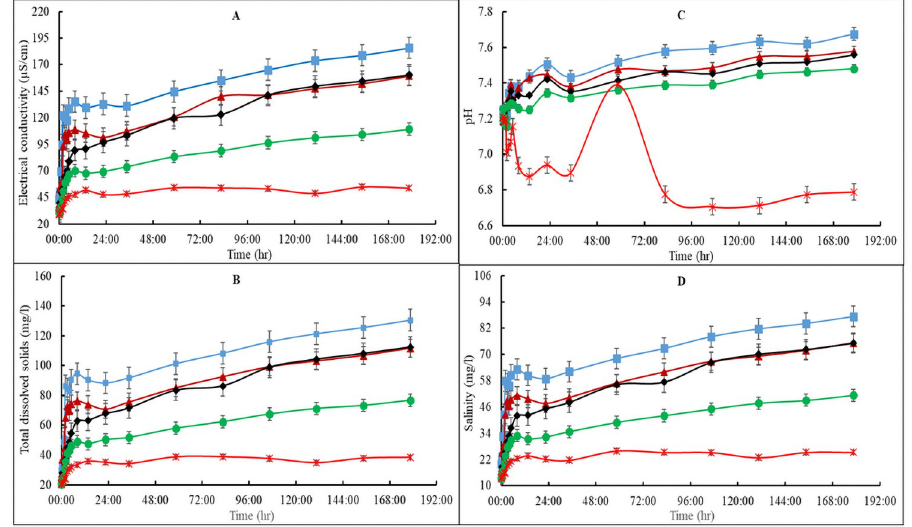
Fig 1. Electric conductivity (A), total dissolved solids (B), salinity (C) and pH (D) of vermicast-sawdust mixed media without addition of Trichoderma viride (group A). A1 (blue line) is 80%vermicast+20%sawdust; A2 (brown line) is 60%vermicast+40%sawdust; A3 (black line) is 40%vermicast+60%sawdust; A4 (green line) is 20%vermicast + 80%sawdust; and A5 (red line) is sawdust alone with n = 3 per experimental replicate. Error bars represent standard